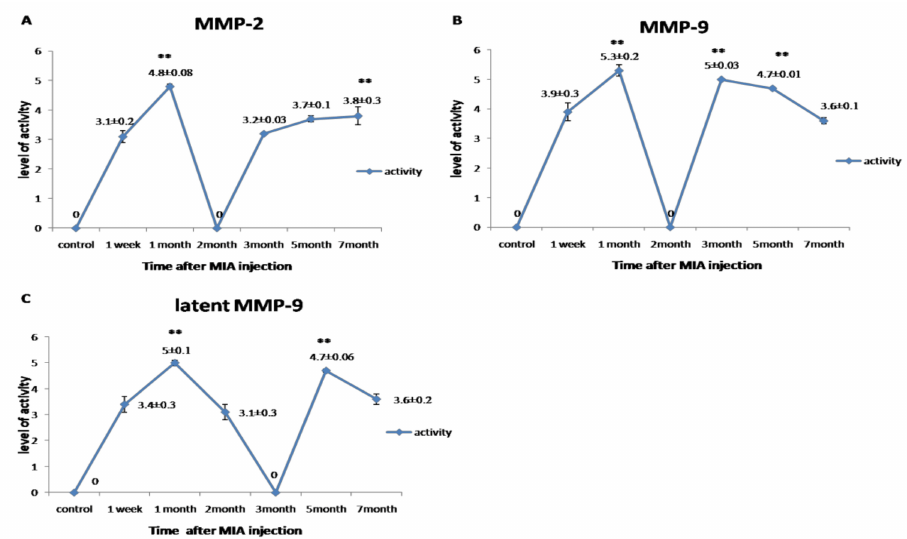
Figure 5. Graphical representation for the changes in the activity of MMPs during the disease progression post-MIA injection at day 0, 1st week, 1st month, 2nd month, 3rd month, 5th month, and 7th month. ( A ) Representing the activity of MMP-2. ( B ) Representing the activity of MMP-9. ( C ) Representing the activity of latent MMP-9. All data are represented as mean ± SEM for triplicate samples ( n = 3). ** denotes significant di ff erence from samples in the 1st week at p < 0.05.